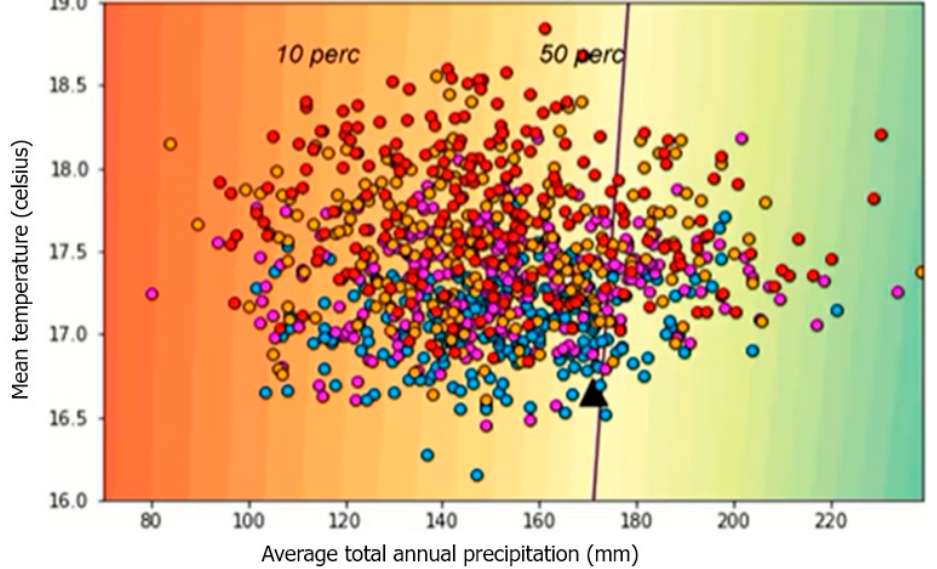
Figure 6. Example of dispersion of predictions of GCMs in terms of annual average precipitation (p) and temperature (t) (adapted with kind permission from [47]). Here the outputs are temporally averaged projections of the SIMGEN weather generator; the forced anthropogenic trend component is inferred from the 50th percentile trend that is projected by GCMs within the CMIP5; dots’ colors correspond to averages along different future periods (blue: 2020–2030; pink: 2030–2040; orange: 2040–2050; red: 2050–2060). Notice that dispersion is very pronounced and that changes with respect to present climate (black triangle) may even result beneficially (to the right of the oblique line marking a threshold of users’ satisfaction). Climatic variability, in addition to the change of average values here represented, opens an additional, broader spectrum of uncertainty (e.g., [48,49] showing that its change is more significant than that of average